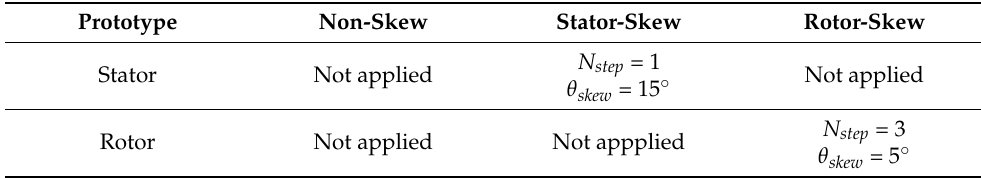
Table 3. Skew designs for the 3